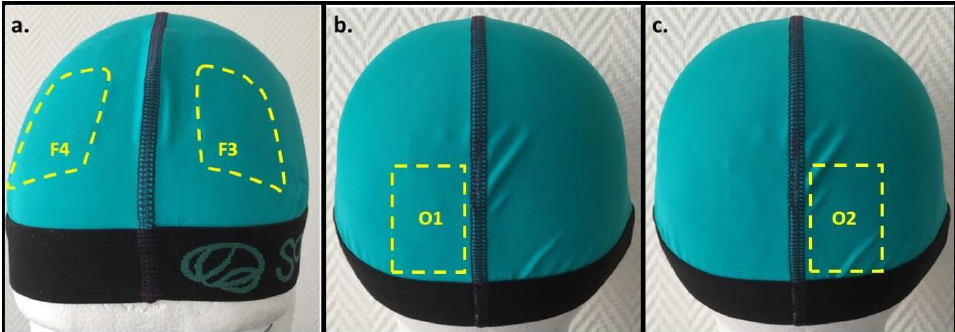
Figure 1. The transcranial direct current stimulation (tDCS) setup with electrodes positioned according to the 10–20 electroencephalography system. ( a ) Prefrontal tDCS: the yellow marked areas correspond to the anode and cathode position over the left (F3) and right (F4) dorsolateral prefrontal cortices, respectively. ( b , c ) Occipital tDCS: the yellow marked areas illustrate the cathode position over the left (O1) or right (O2) occipital cortex; the anode is placed over the contralateral supraorbital area (not shown).